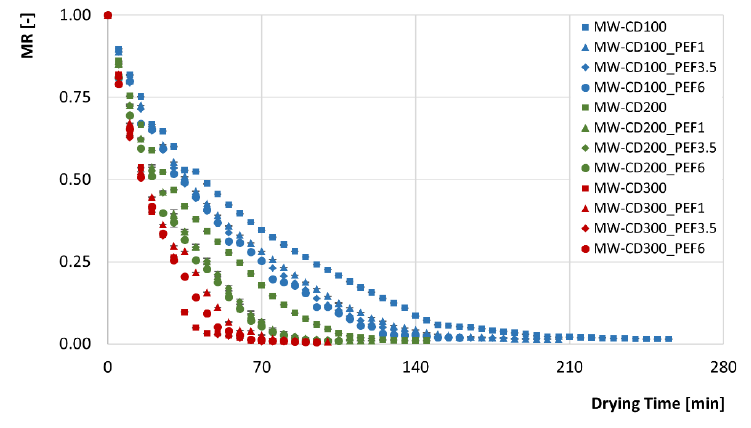
Figure 1. Drying curves of microwave-convective drying of apples untreated or PEF-pretreated. Table 3. The results of statistical tests of fitting the equations of the response surfaces to the values obtained experimentally ( α = 0.05); R 2 (determination coefficient), CV (coefficient of variation).